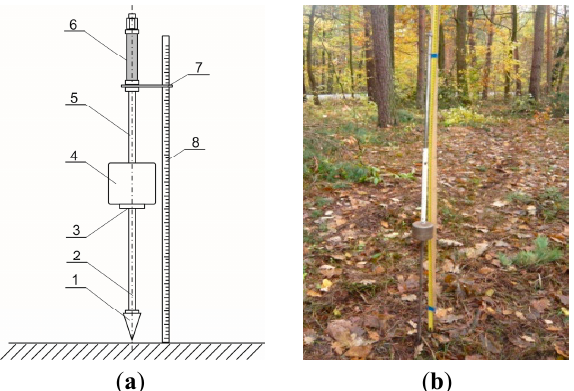
Figure 3. Cone impact penetrometer: ( a ) scheme of the penetrometer: 1—cone, 2—introductory rod, 3—bumper, 4—weight, 5—guide, 6—handle, 7—indicator, and 8—linear gauge; ( b ) penetrometer